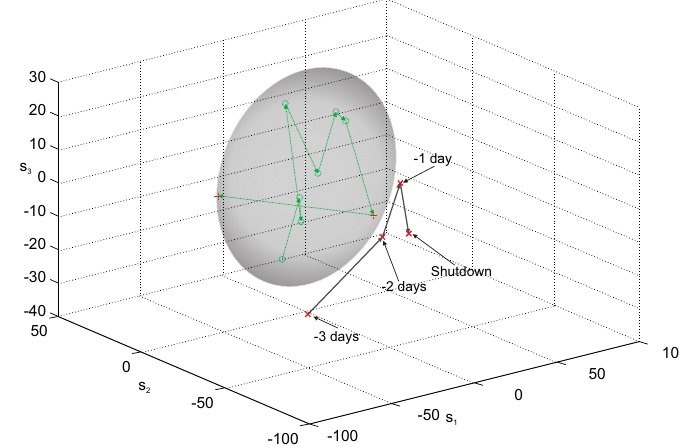
Figure 5. Two process variables from the period from 17th November 2011 to 4th December 2011, after splitting into one-day batches: ( a ) Lift in the hearth chamber. ( b ) Flow of the water feeding the boiler.